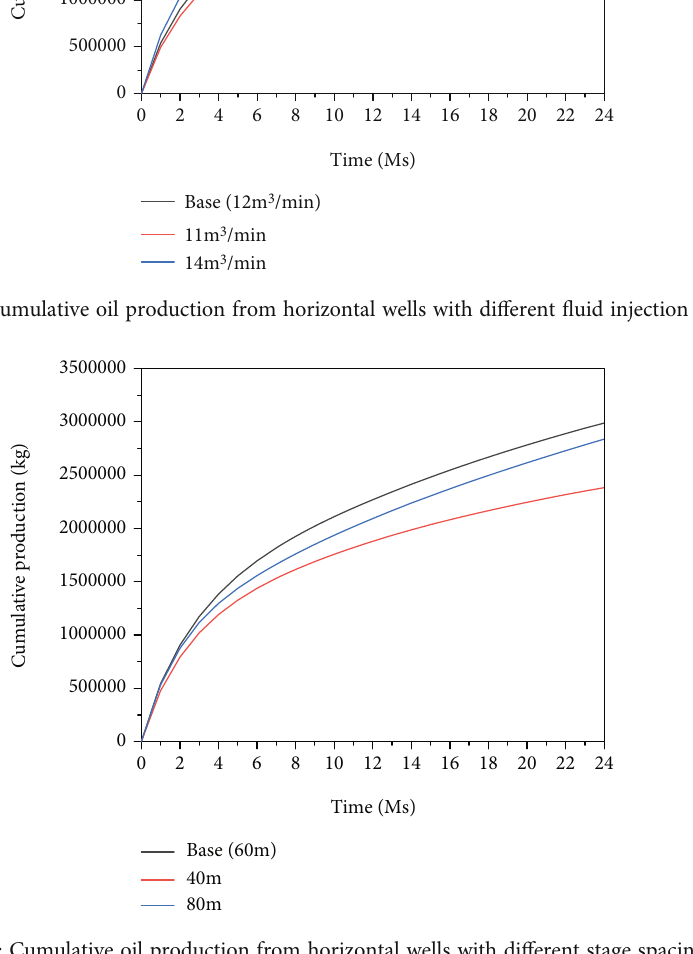
Figure 12: Cumulative oil production from horizontal wells with di ff erent stage spacings.